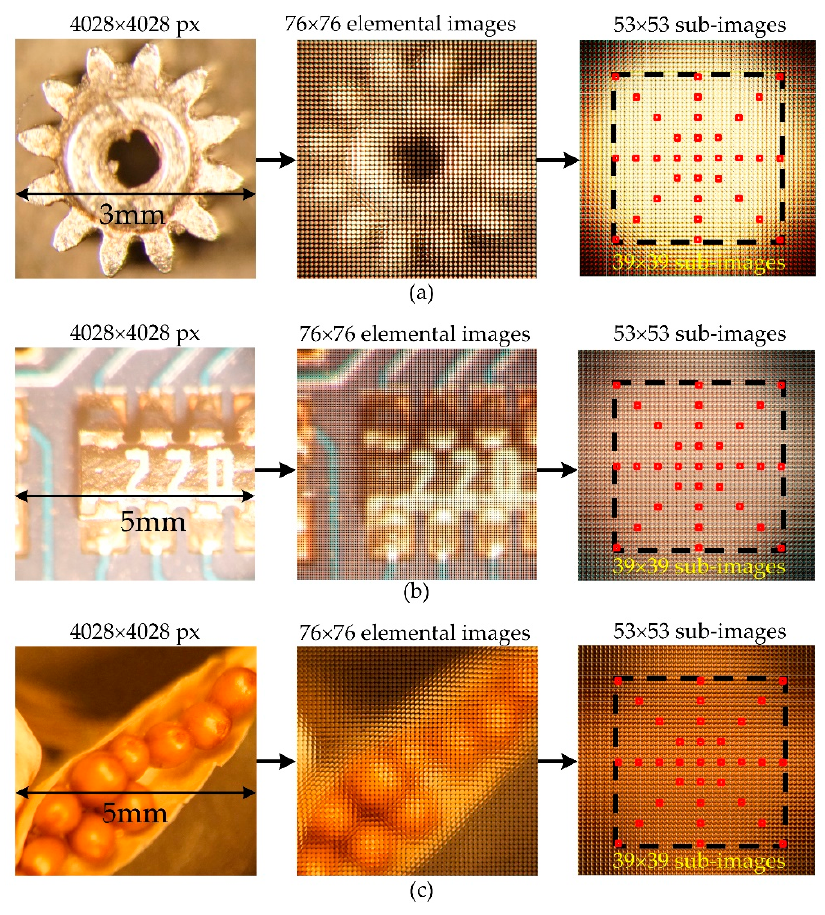
Figure 7. The process of generating test data. Two-dimensional images (left); EIAs (middle); OVIs (right) of the of the ( a ) gear, ( b ) microchip, and ( c ) seedpod. Table 1. Comparison RMSE * between the state-of-the-art networks and the proposed model.